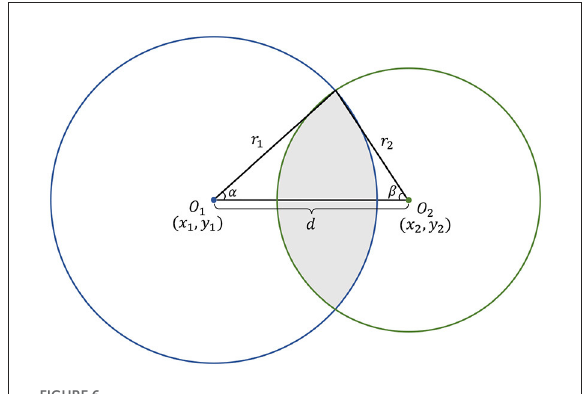
FIGURE6 The schematic diagram of